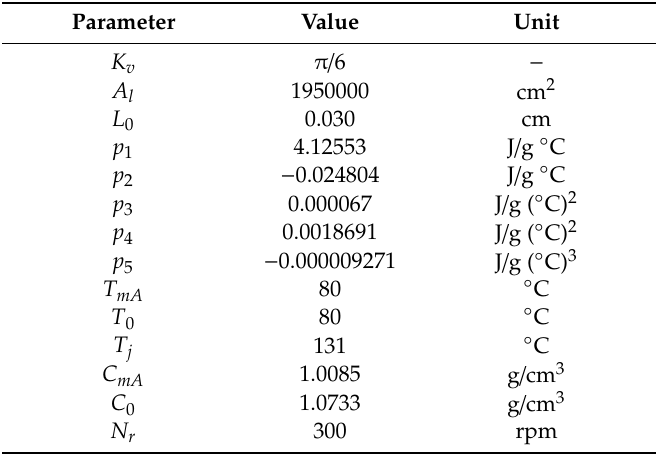
Table 2. Process parameters to solve the population, mass, and energy balances.